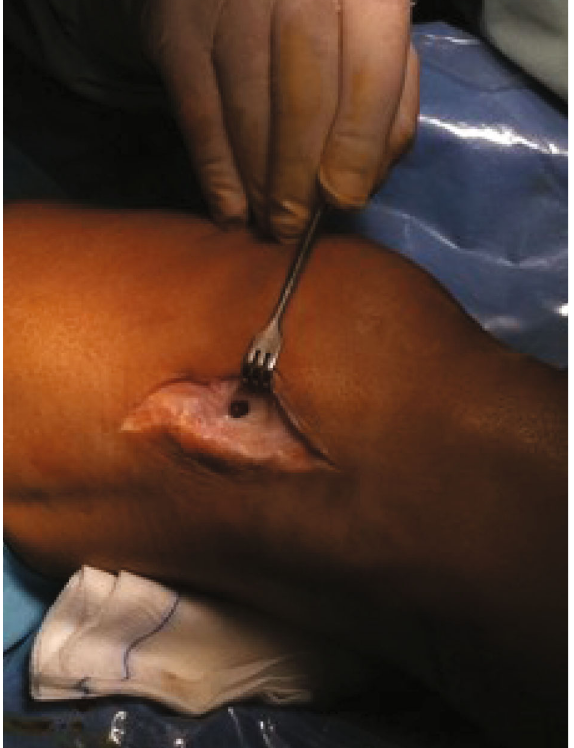
Figure 3: Intraoperative picture showing the cortical bone defect that originates the cyst at the lateral aspect of the lateral femoral